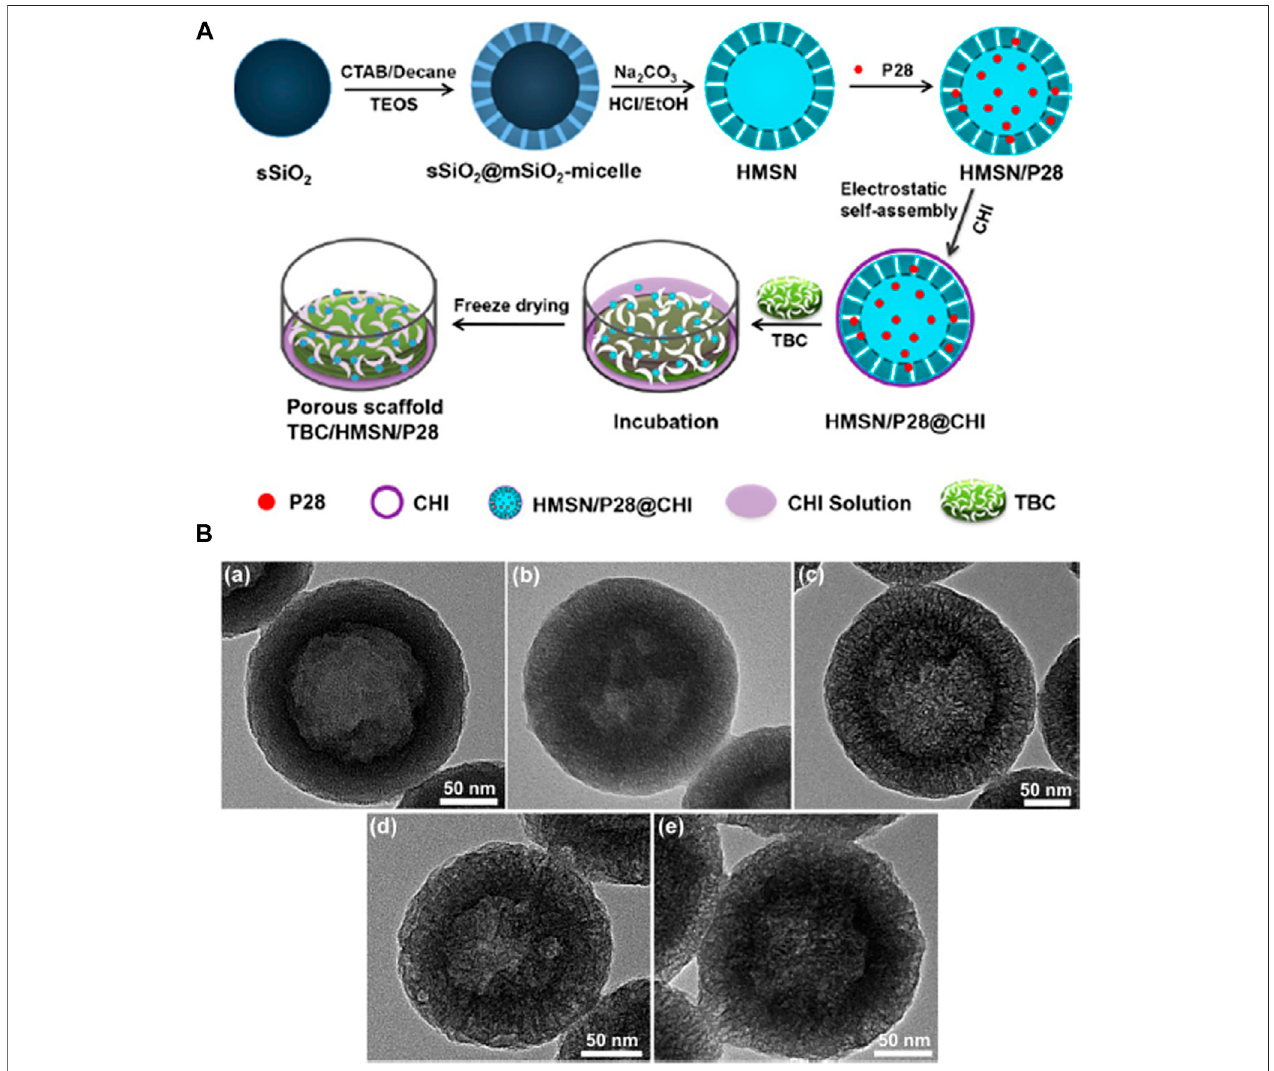
FIGURE 8 | (A) Illustration showing the synthetic procedure of the TBC/HMSN/P28 composite material. (B) TEM images of the HMSNs synthesized through varying molar ratios of decane/CTAB: a) 0.0, b) 0.5, c) 1.0, d) 2.0, and e) 4.0. Reprinted with permission from Cui et al. (2018). Copyright © 2017 American Chemical